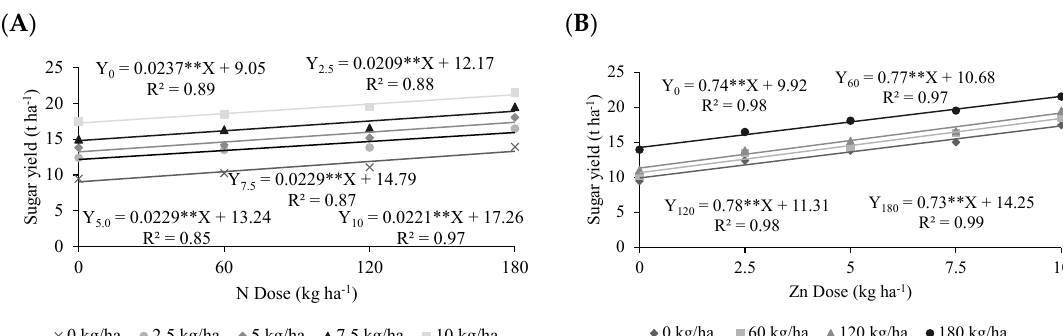
Figure 5. Sugar yield of sugarcane (ratoon crops) in response to nitrogen ( A ) and zinc ( B ) fertigation doses, under field conditions in Jataí, GO, Brazil. ** significant at p < 0,01 probability according to the F test. Doses of Zn, Y 0 : 0 kg ha − 1 of Zn, Y 2.5 : 2.5 kg ha − 1 of Zn, Y 5.0 : 5.0 kg ha − 1 of Zn, Y 7.5 : 7.5 kg ha − 1 of Zn and Y 10 : 10 kg ha − 1 of Zn ( A ). Doses of N, Y 0 : 0 kg ha − 1 of N, Y 60 : 60 kg ha − 1 of N, Y 120 : 120 kg ha − 1 of N, Y 180 : 180 kg ha − 1 of N ( B ).